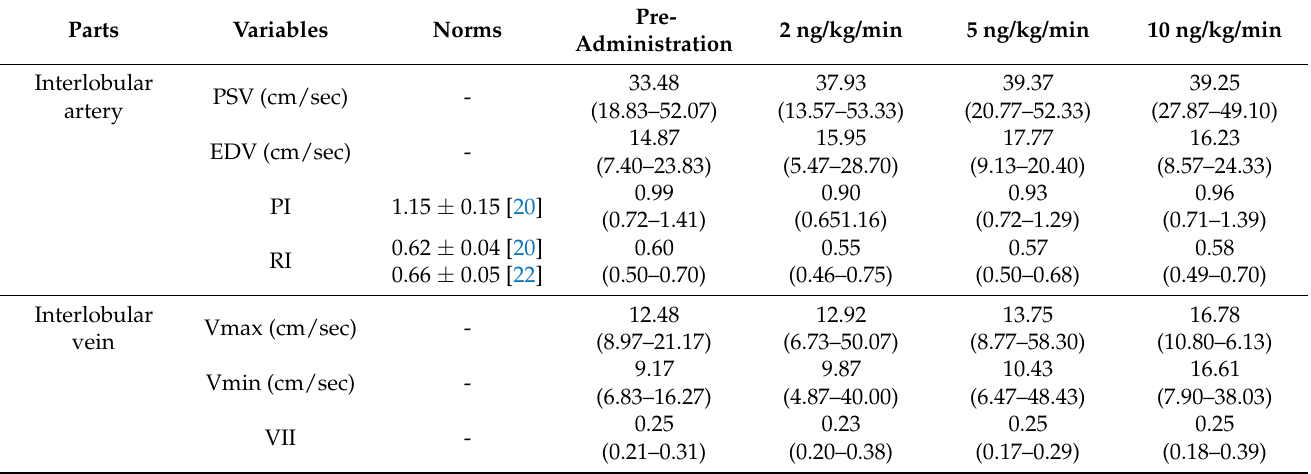
Table 1. Comparison of renal blood flow parameters using the pulsed Doppler method at each time